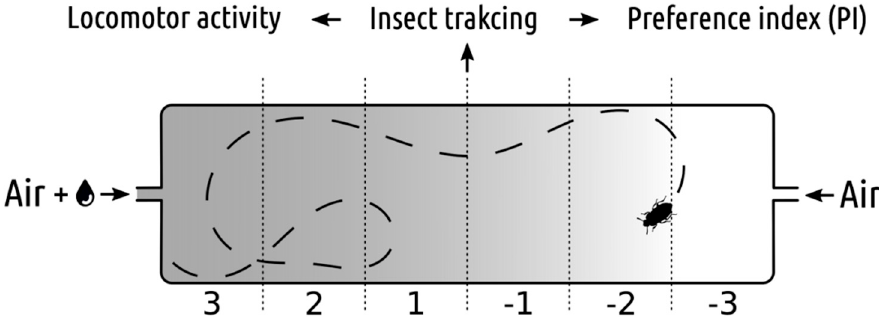
Figure 1. Schema of experimental chamber with air inputs (with or without EOs) and zones values for preference index (PI) quantification.